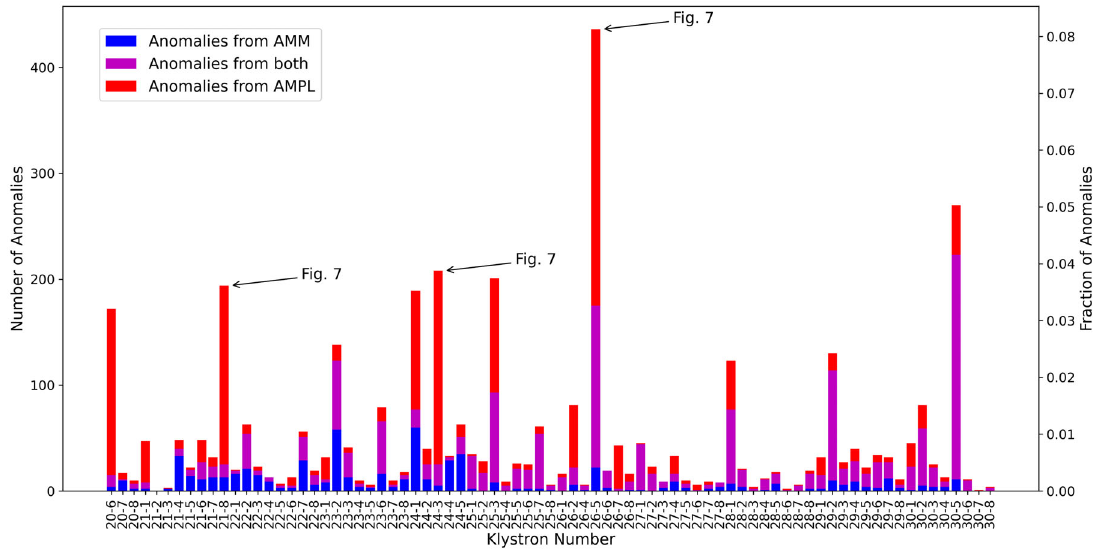
FIG. 6. Count of anomaly candidates identified by either the AMM bit, the AMPL signal, or both that were labeled anomalies using our anomaly detection routine on the BPM data. The red part of the bar is anomaly candidates detected only by the AMPL signal, the blue part of the bar is anomaly candidates detected only by the AMM bit, and the magenta part of the bar is anomaly candidates that were detected by both. The klystrons are enumerated along the LCLS accelerator from low energy (left) to high energy